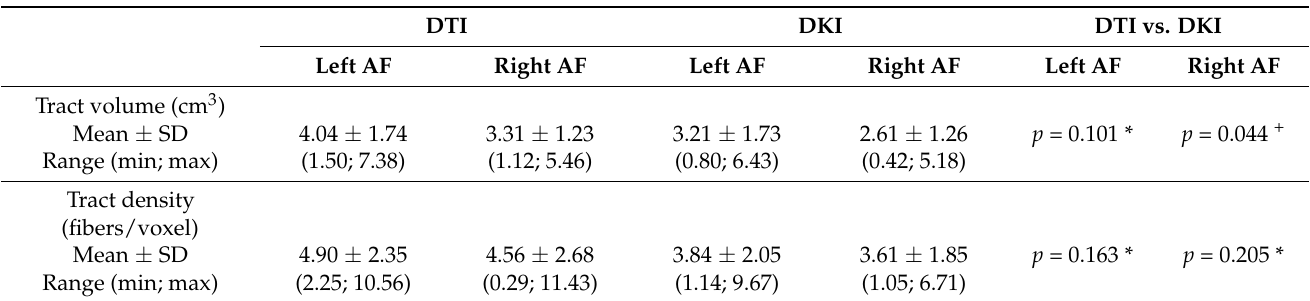
Table 5. Results of fiber tractography of the arcuate fascicle (AF) in healthy volunteers.